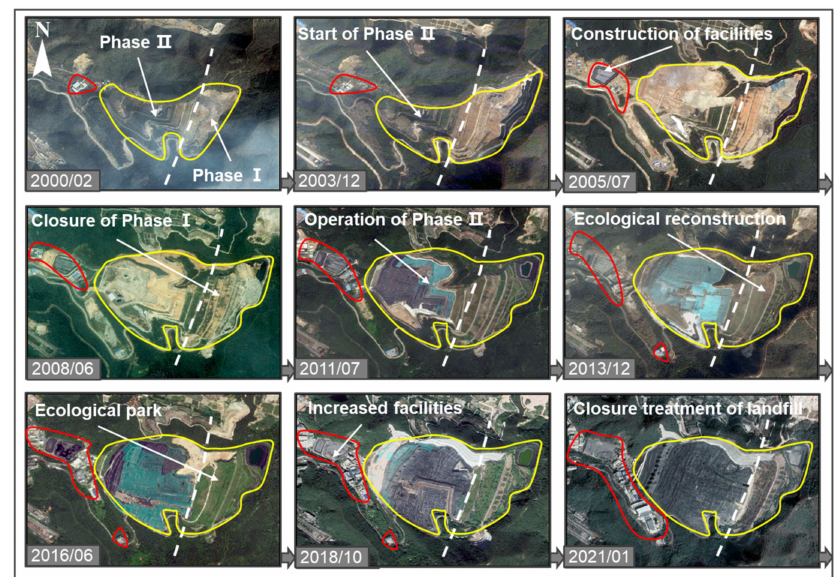
Figure 2. Evolution of Tianziling MSW landfill based on satellite remote sensing images. The yellow lines indicate the boundaries of the landfill and the red lines show the development of construction facilities around the